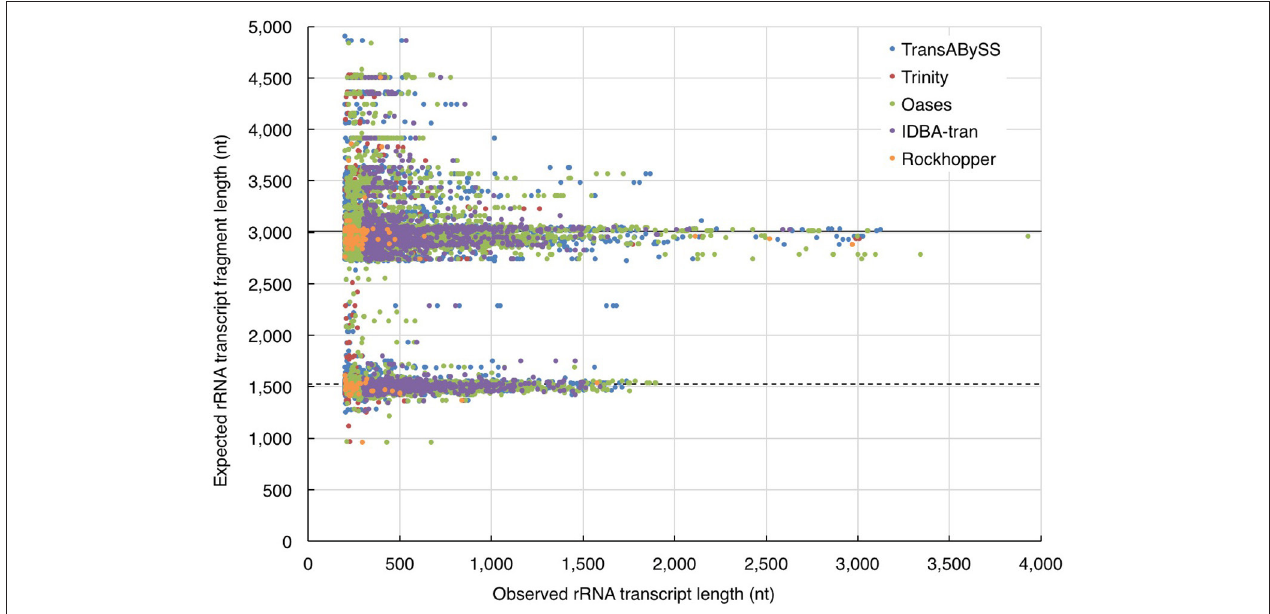
FIGURE 5 | Evaluation of ribosomal RNA (rRNA) transcript length. The length of quality-filtered rRNA transcripts (observed) was compared to the maximum length of qualified BLASTn best hits of the query transcript sequence (expected). The solid and dotted lines denote the average length of large and small subunits (LSU and SSU) of rRNA genes calculated from the all respective qualified BLASTn hits.